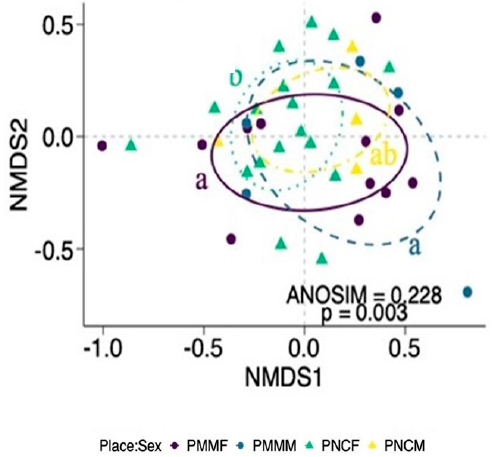
Figure 3. Variation in the food composition between female and male coatis ( Nasua nasua ) in two different parks, PMM and PCN. Letters represent statistical differences between groups by multiple ANOSIM tests. F—Female, M—Male. PMMF—PMM and female coati (solid line), PMMM— PMM and male coati (dashed line), PNCF—PNC and female coati (dotted line), PNCM—PNC and male coati (dashed–dotted line). PMMF, female coati from Parque Municipal Mangabeiras; PMMM, male coati from Parque Mu-nicipal Mangabeiras; PNCF, female coati from Parque Nacional do Caparaó; PNCM, male coati from Parque Nacional do Caparaó. Table 2. Likelihood-ratio tests comparing the percentage occurrence of each food category in- gested by female and male coatis ( Nasua nasua ) in two different parks (PMM and PNC). Sex—male and female; Place—PMM and PNC. * Significant p-value.